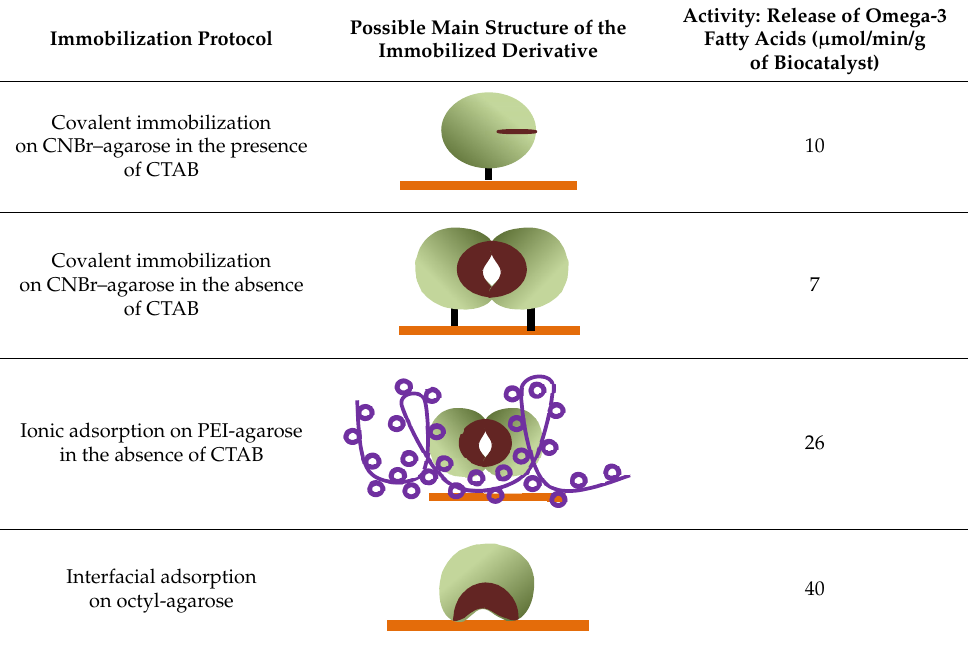
Table 4. Release of omega-3 fatty acids by the enzymatic hydrolysis of krill oil. Possible Main Structure of Immobilization Protocol